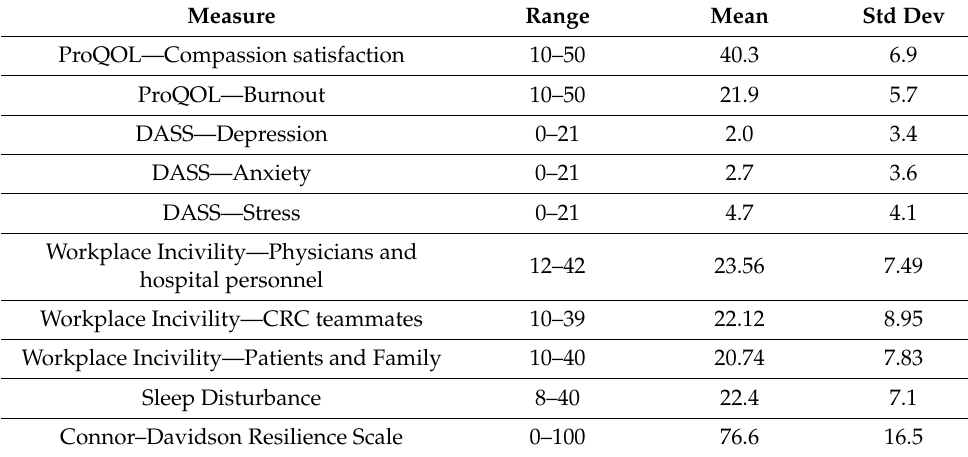
Table 2. Range and mean scores for all measures. DASS = Depression, Anxiety, and Stress Scale; ProQOL = Professional Quality of Life; Std Dev = standard